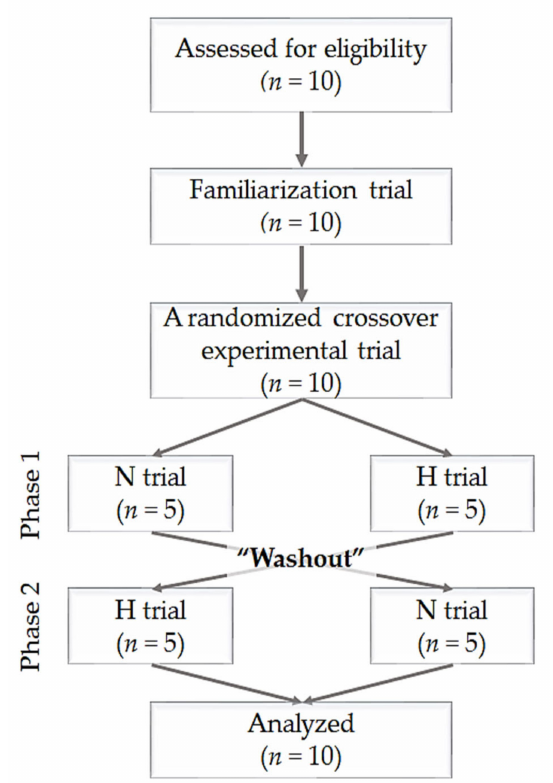
Figure 1. The flow diagram of the consolidated standards of reporting trial. N trial: Pilates program under normoxic conditions, H trial: Pilates program under hypoxic